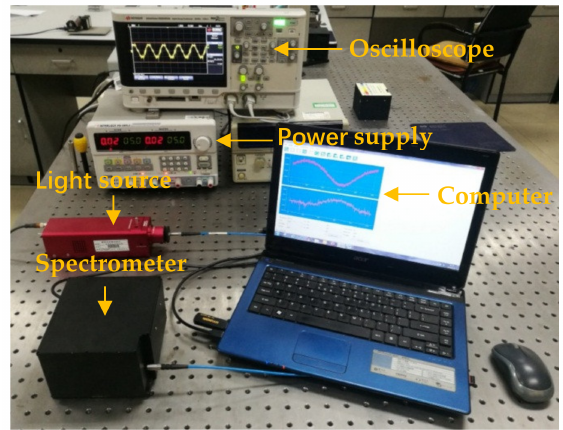
Figure 20. Photo of the assembled micro NIR